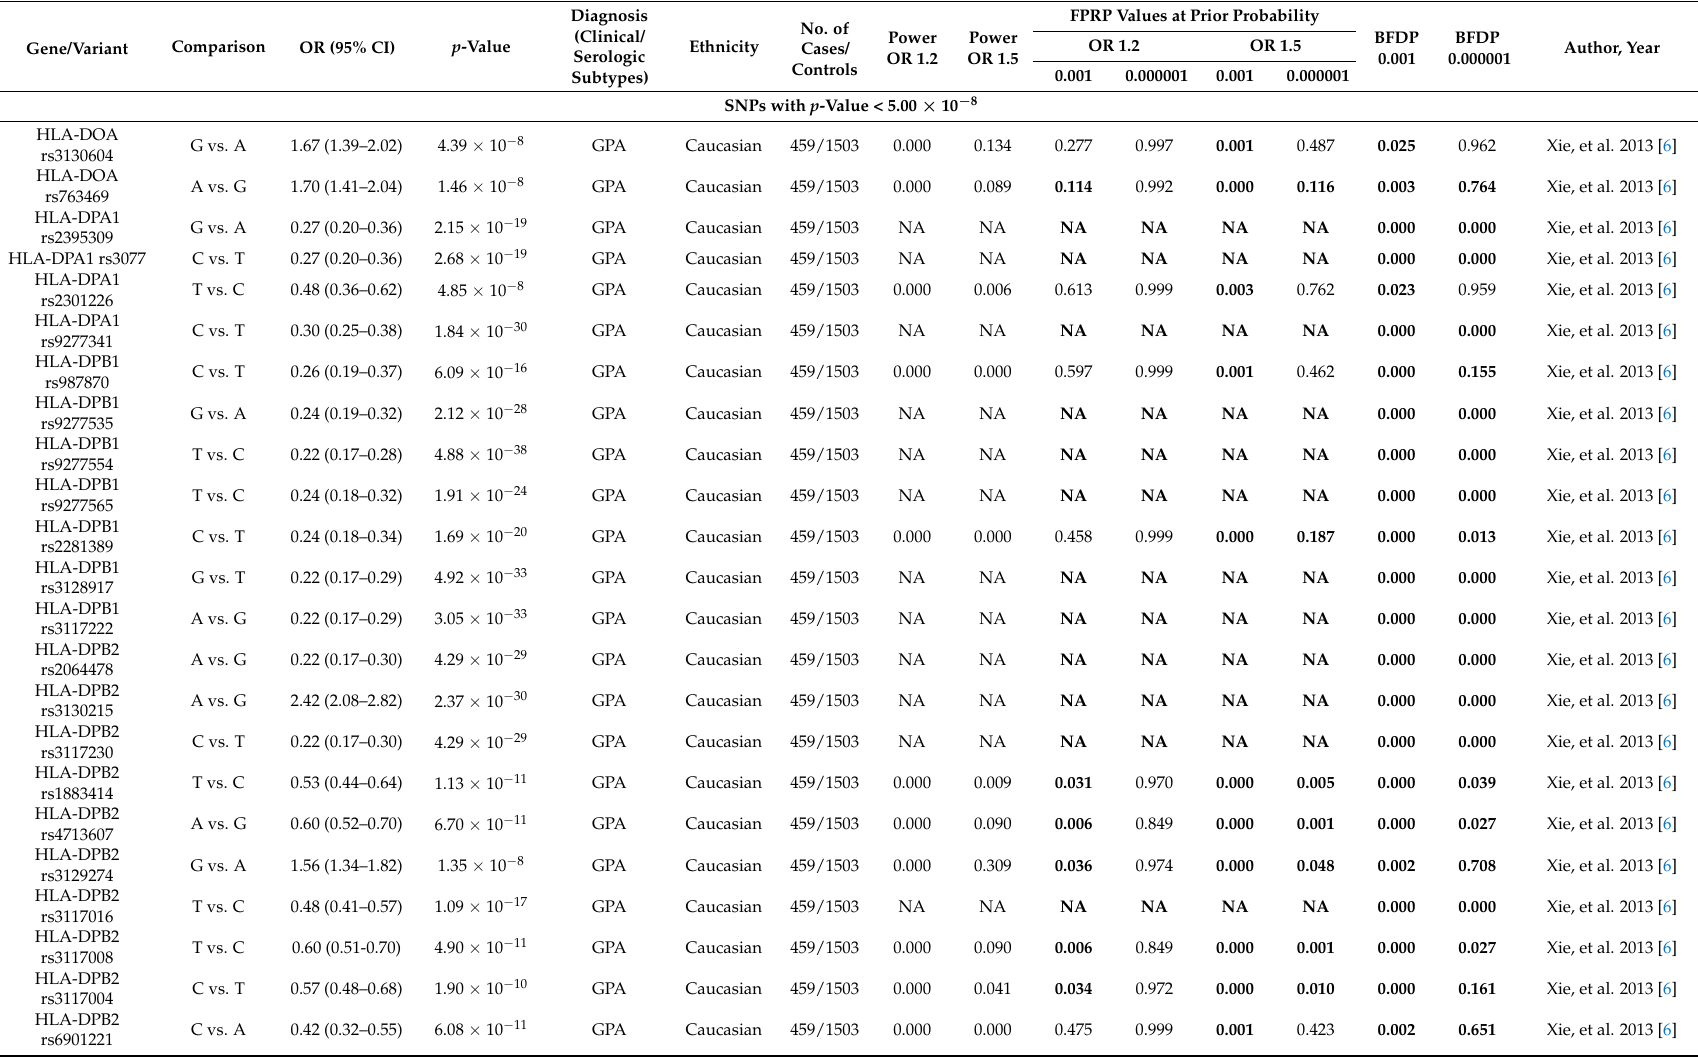
Table 4. Re-analysis of the SNPs discovered in genome-wide association studies of patients with GPA. Noteworthy genetic variants with satisfied FPRP or BFDP values are presented. Xie et al. only provided GPA SNPs with odds ratios (ORs) and 95% confidence intervals